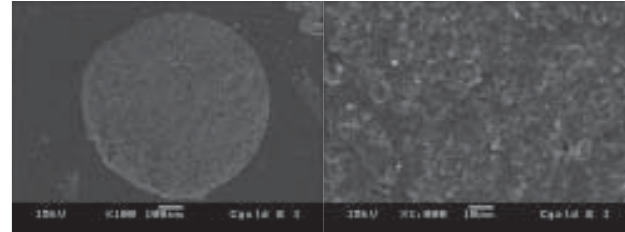
Fig 3. SEM of Cergogold: Cohesive fracture pattern (arrow) (A- Original magnification X 100; B- Original magnification X 1000).